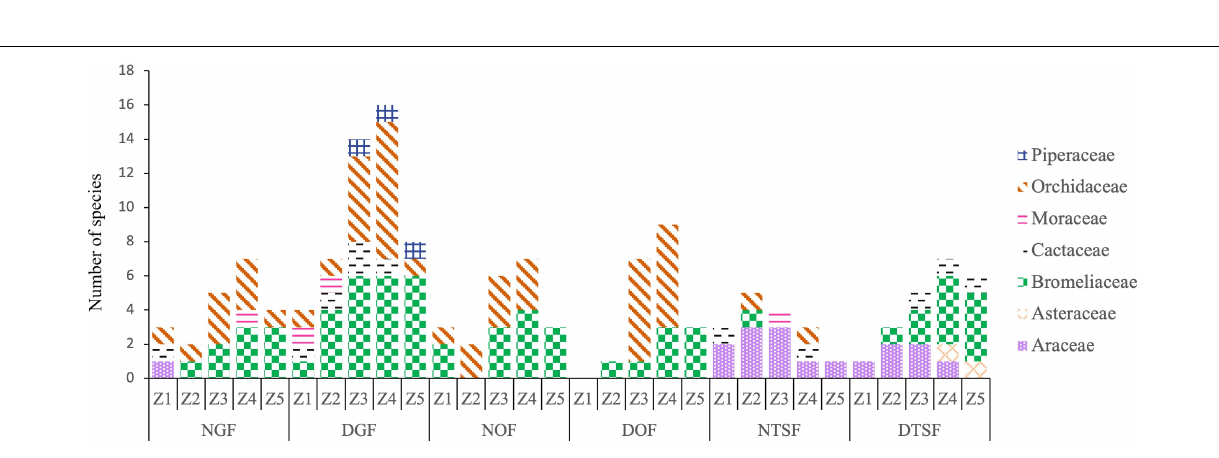
Frontiers in Forests and Global Change |